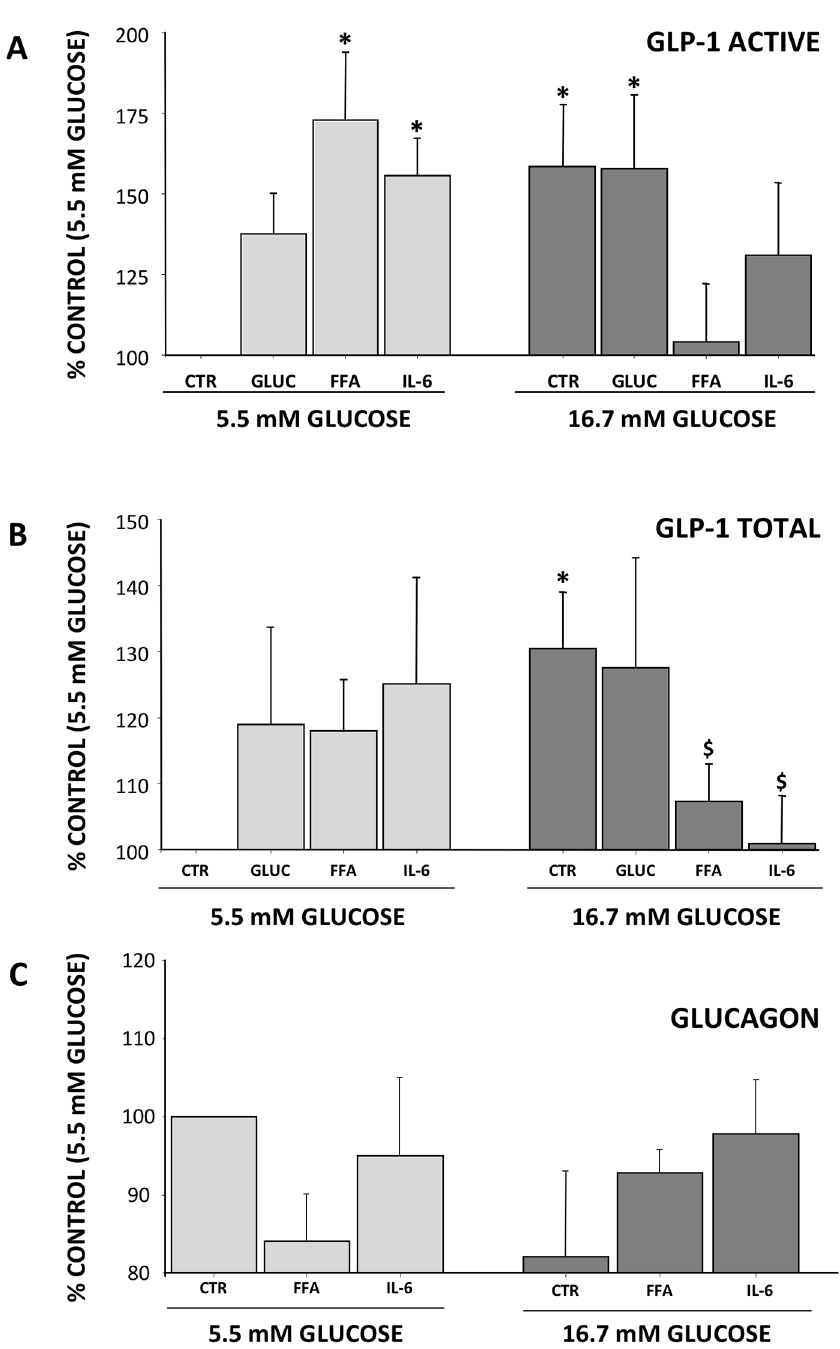
Fig 3. Effect of metabolic/hormonal pertubation on GLP-1 secretion. Cells were incubatedfor 16 h in the presenceof 5.5mM or 16.7mM, in the additionalpresenceof glucagon,FFA and IL-6; hormonesecretionat medium was determined by ELISA method using specific kits. Panel A: GLP-1 Active, Panel B: GLP-1 Total and Panel C: Glucagon.Results are % of control (cells incubatedin 5.5mM glucose) and expressedas MEAN ± SEM, n = 4. * p < 0.05comparedto 5.5mM glucosecontrol; $p < 0.05compareto FFA (5.5mM glucose).